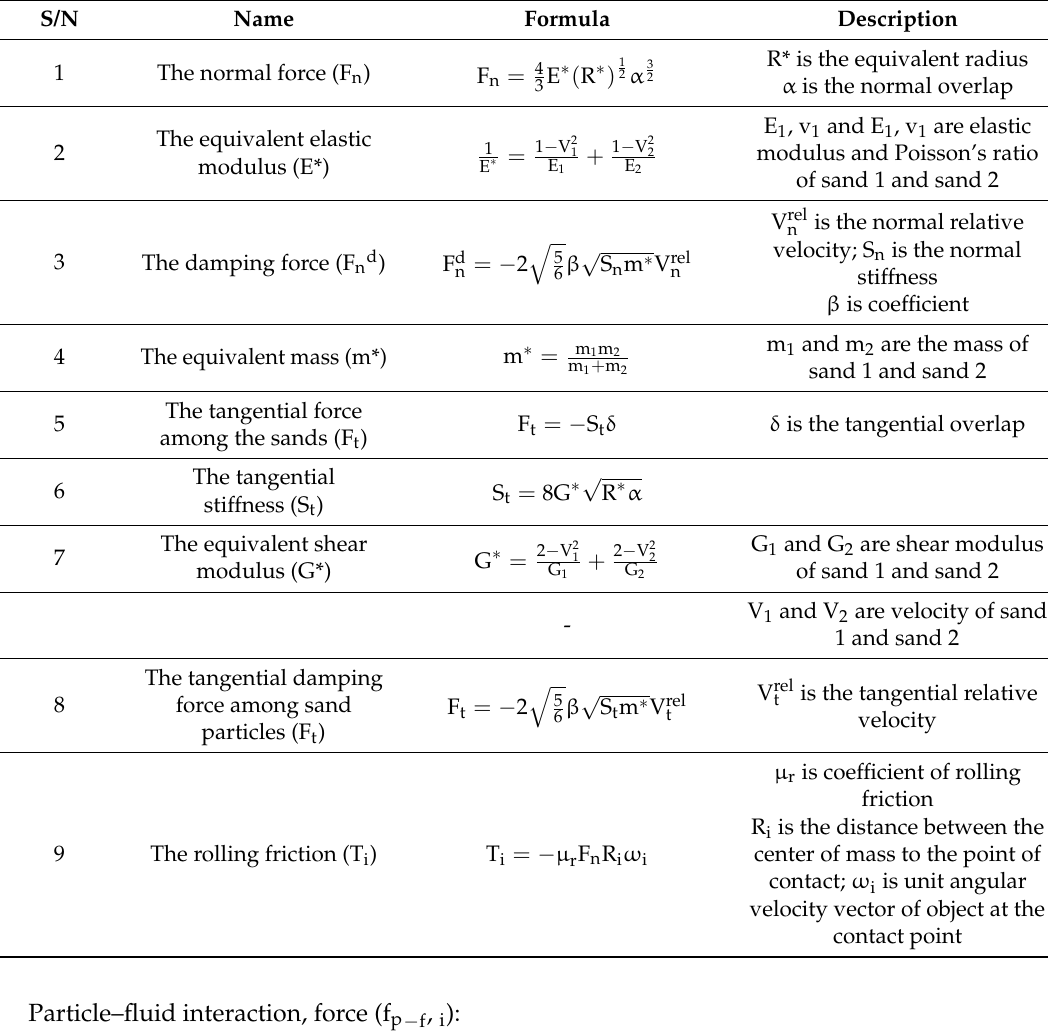
Table 4. Equations and